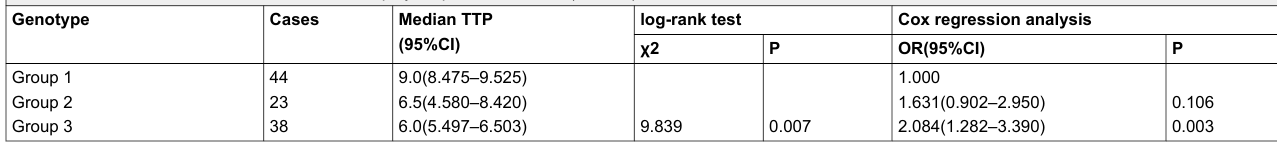
Table 5: The combination of GSTP1 and XRCC1 polymorphisms and TTP (n = 105).